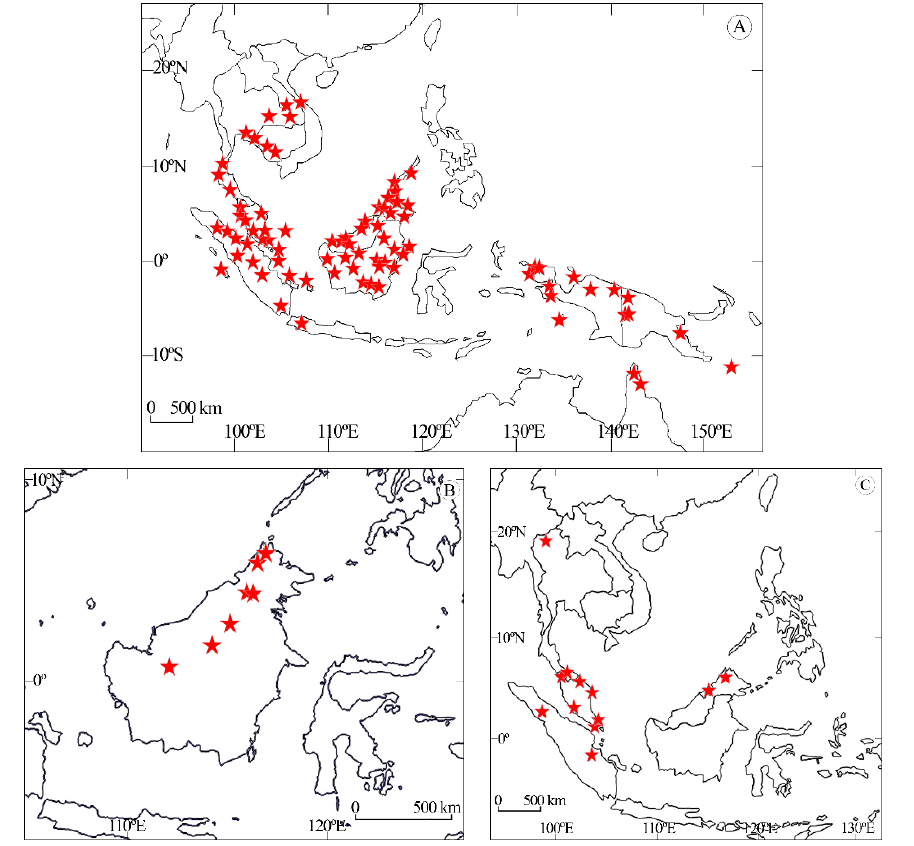
Figure 6. Distribution maps: ( A ) Bromheadia finlaysoniana ; ( B ) B. cecieliae ; ( C ) B. truncata . Red stars represent localities provided in Table A1.